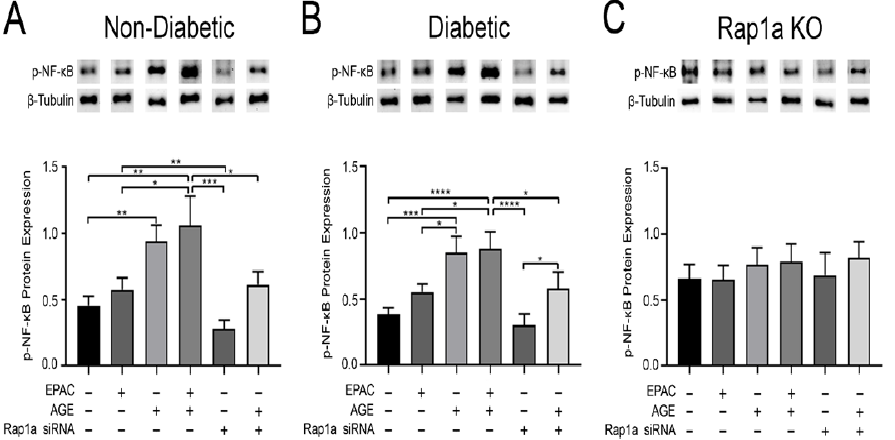
Figure 4. The presence of Rap1a mediated an AGE/RAGE induced increase in p-NF- κ B expression. Cardiac fibroblasts isolated from ( A ) non-diabetic, ( B ) diabetic, and ( C ) Rap1a KO hearts were either untreated or treated with pharmacological modifiers, either solo or in combination: EPAC (100 µ M), EPAC + AGE (100 µ M and 0.5 mg/mL, respectively), Rap1a siRNA (100 nM), or Rap1a siRNA + AGE (100 nM and 0.5 mg/mL, respectively). Phosphorylation of NF- κ B (65 kDa) was assessed and protein expression was normalized to β -tubulin (55 kDa) expression. Data depicted for exogenous AGE treatment group for non-diabetic and diabetic fibroblasts were previously presented Figure 1. Representative western blot images are shown above graphs but are not displayed as a continuous blot due to running order on the blot not aligning with graphical order of samples. However, original western blot images are available at DOI:10.6084/m9.figshare.12625409. Graph depicts mean ± SEM with n = 5–9 and statistical analysis consisted of one-way ANOVA followed by a Fisher’s protected least significant difference post hoc (* p < 0.05, ** p < 0.01, *** p < 0.001, **** p <